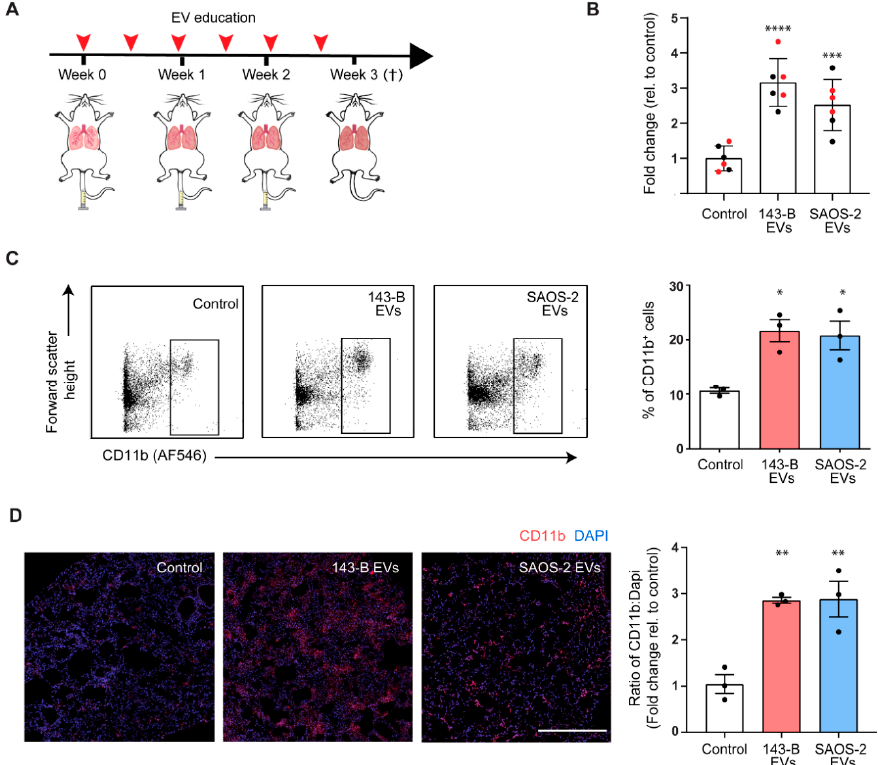
Figure 3. Osteosarcoma cell-derived extracellular-vesicles (EVs) promote accumulation of bone marrow-derived cells in the lungs. ( A ) Schematic illustration of the experimental setup. Mice were treated with either PBS, 143-B EVs or SAOS-2 EVs (10 µg) 2 times a week for 3 weeks after which mice were euthanized. ( B ) Relative mRNA expression levels of integrin alpha M gene encoding CD11b ( Itgam ) in bulk lung RNA in mice of indicated treatment groups. Transcript levels are normalized to Gapdh and expressed as fold change relative to control mice. n = 6, mice were pooled from two independent experiments indicated in red and black ( C ) Representative flow cytometric profile (left panel) and quantification (right panel) of CD11b + cells isolated from lungs of mice from indicated treatment groups; n = 3 mice per group. ( D ) Representative immunofluorescence images (left panel) and quantification (right panel) of CD11b + cells (red) and nuclei (blue) in lungs of mice from indicated treatment groups. Scale bar, 500 µm. (*, p < 0.05, **, p < 0.01, ***, p = 0.0001, ****, p < 0.0001, Bonferroni’s one-way ANOVA test). These results demonstrate that both 143-B and SAOS-2-cell-derived EV education mobilizes CD11b + Gr-1 + immune cells to the lungs of naïve mice, recapitulating the effects of a primary tumor in mice. 2.4. Osteosarcoma Cell-Derived EV Education Does Not Alter the Primary Tumor Growth and Metastasis of Osteosarcoma Cells in a Spontaneous Metastatic 143-B Mouse Model To further examine the effects of osteosarcoma cell-derived EV education on primary tumor growth and metastasis, we intratibially injected mice with 143-B cells after three weeks long treatment with either vehicle, 143-B or SAOS-2 EVs (Figure 4A). Additionally, mice were treated with vehicle or EVs for 1 week after TCI. Pre-treatment with EVs did not influence primary tumor growth kinetics, the final primary tumor volume or the extent of bone osteolysis (Figure 4B). Furthermore, although